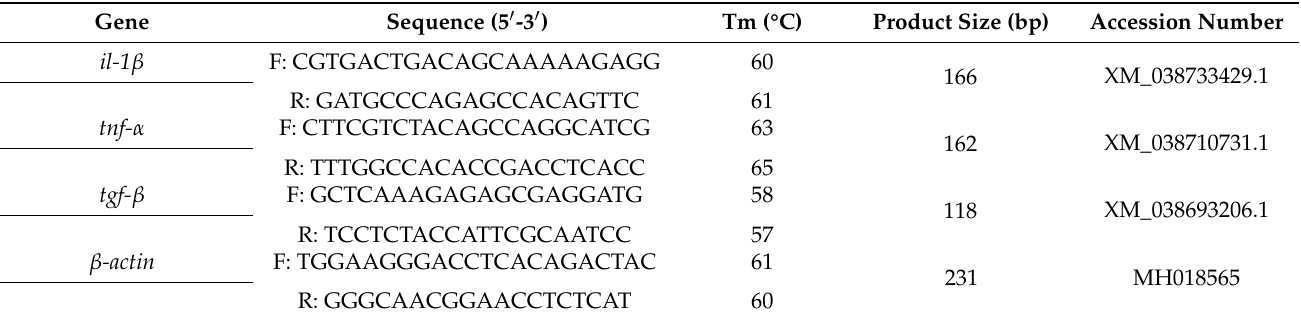
Table 2. Real-time PCR primers sequences